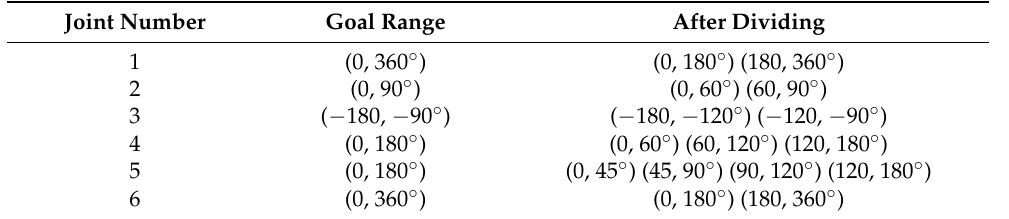
Table 3. Joint space division of